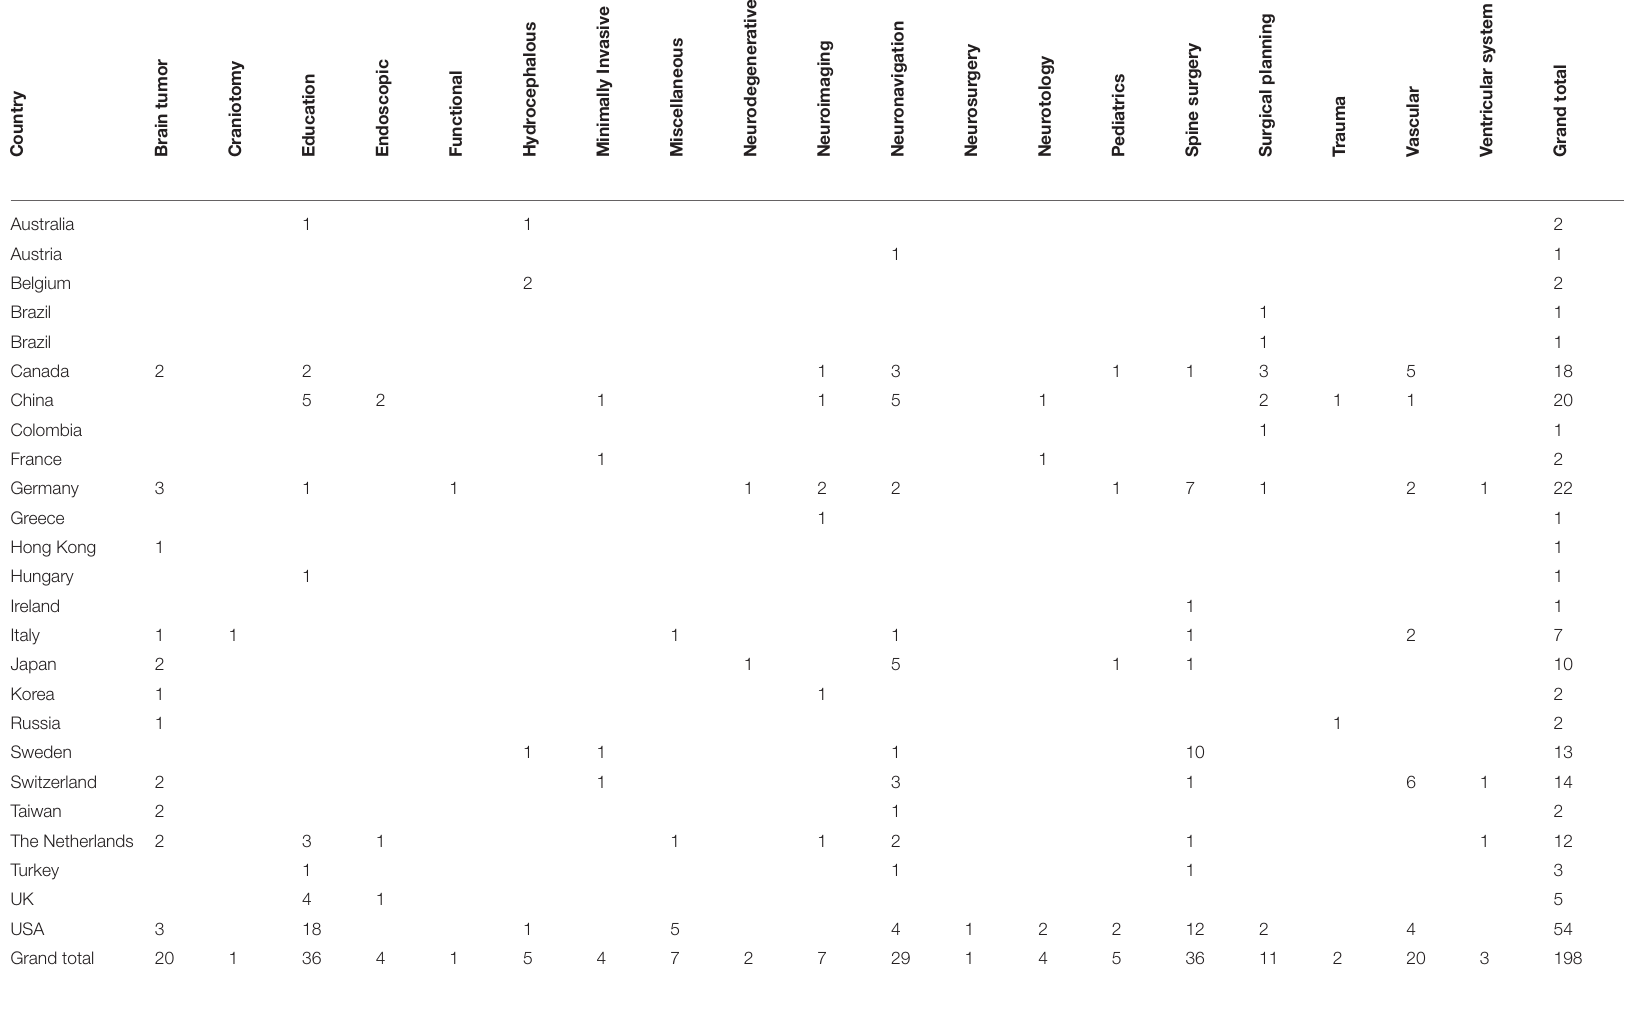
TABLE 4 | Number of publications that could be retrieved from the search as stratified by the country of publication and field of